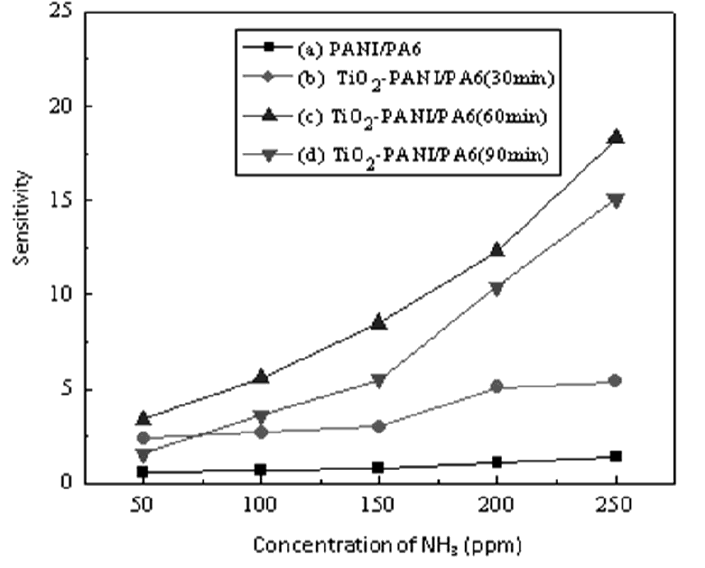
Figure 8. The effect of NH